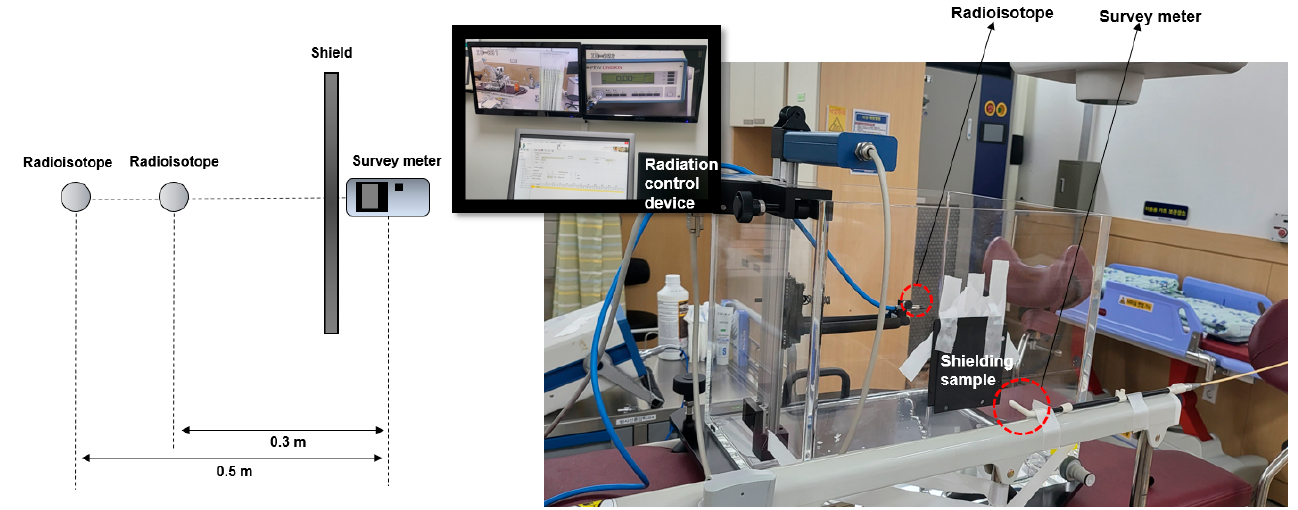
Figure 2. Geometric composition of the evaluation of the γ -ray shielding of samples.